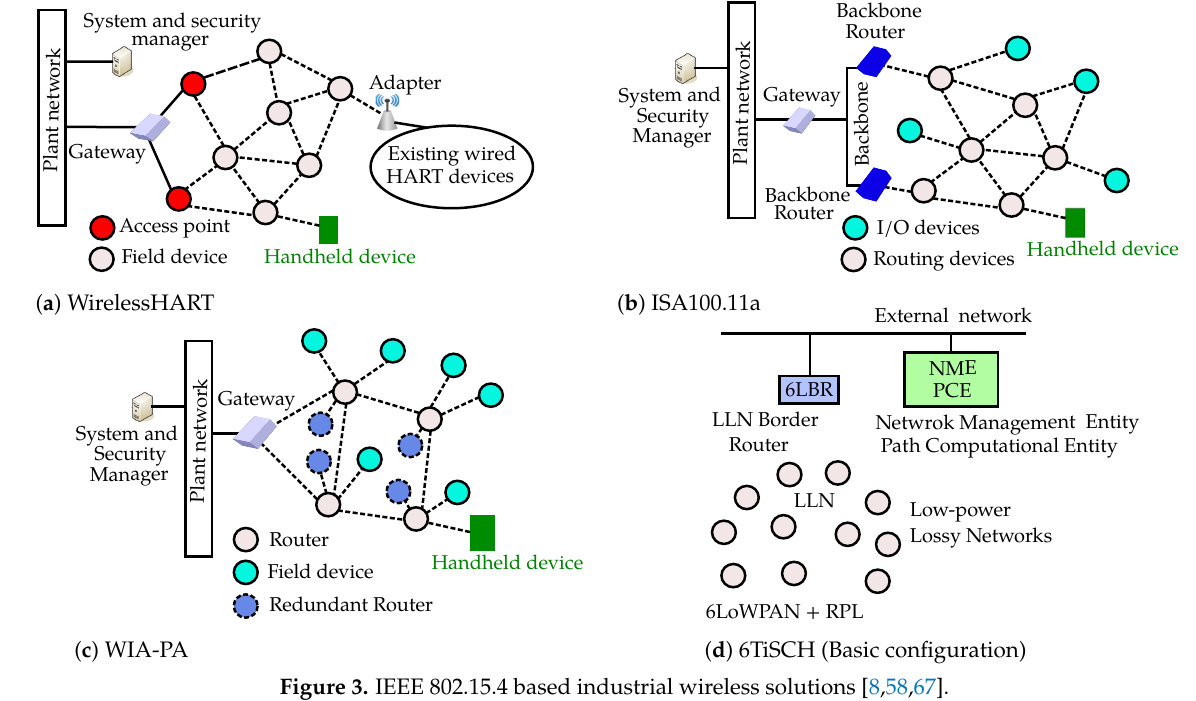
Figure 3. IEEE 802.15.4 based industrial wireless solutions